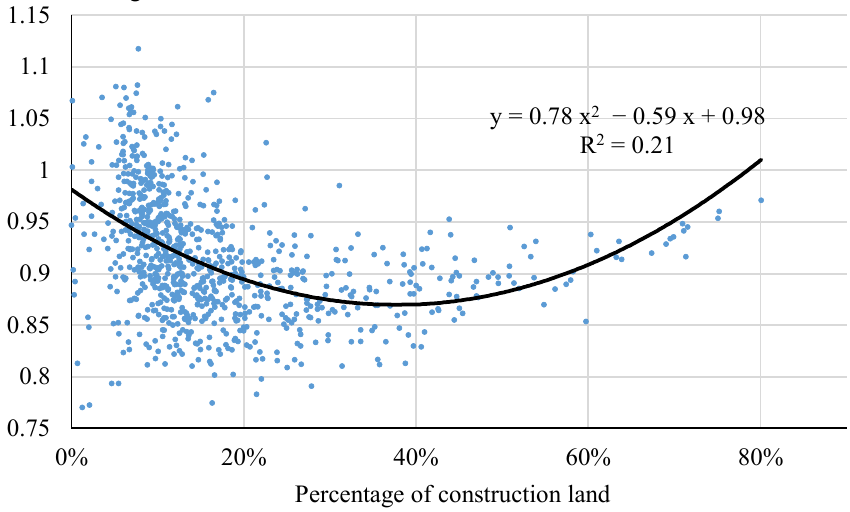
Figure 8. Average neighboring effect with the percentage of construction land by village.